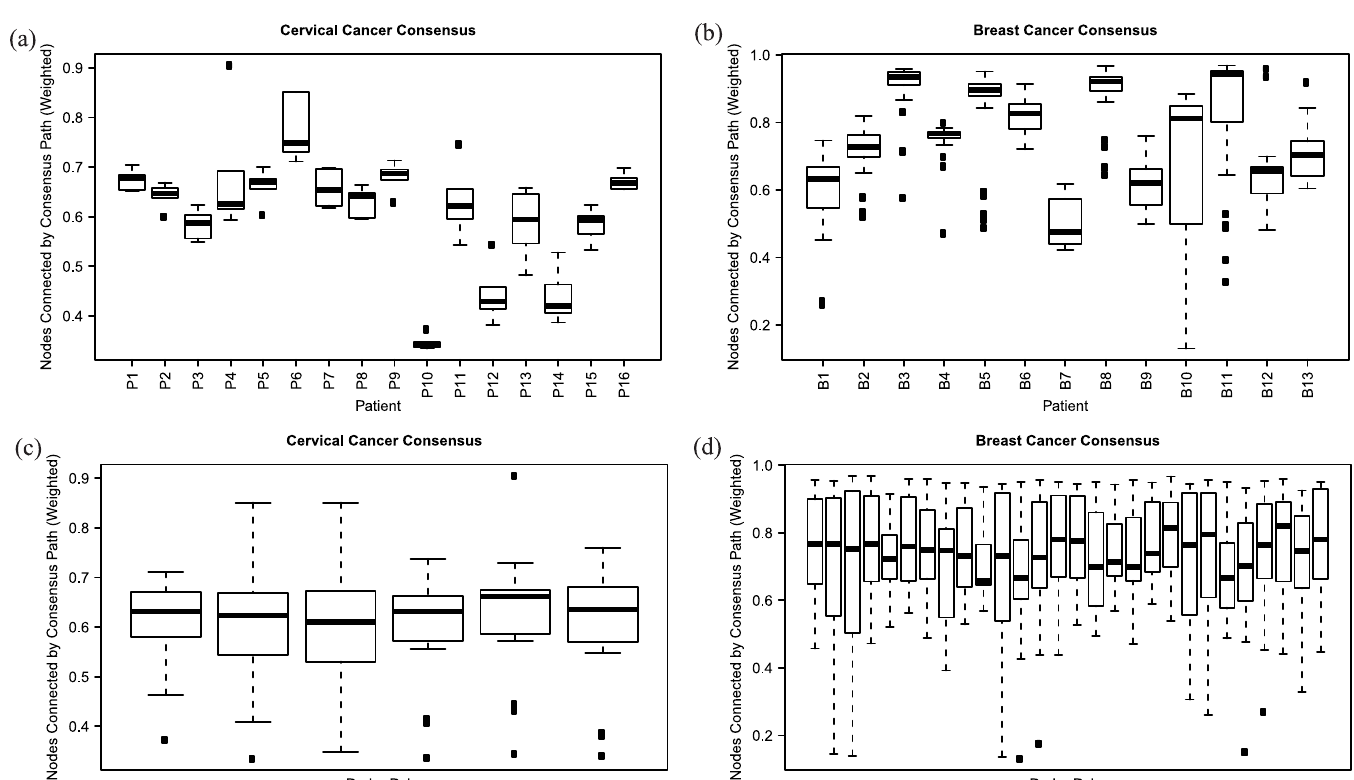
Fig 3. Weighted consensus path values quantifying similarity of trees across progression states. (a) CC weighted consensus path statistics separated by patient, with box-and-whisker plots showing variability by gene pair for each patient. (b) BC weighted consensus path statistics separated by patient, with box-and-whisker plots showing variability by gene pair for each patient. (c) CC weighted consensus path statistics separated by gene pair, with box-and-whisker plots showing variability by patient for each gene pair. (d) BC weighted consensus path statistics separated by gene pair; for each of 28 gene pairs going along the x-axis, there is a box-and-whisker plot showing variability by patient.